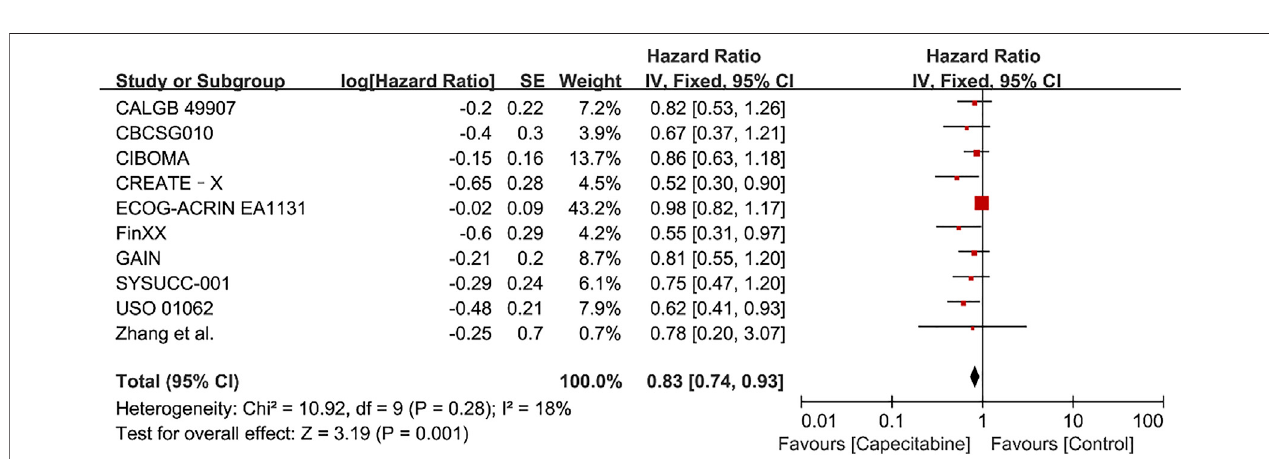
FIGURE 5 | Forest plots for the overall survival (OS) rate in the comparison between chemotherapy with capecitabine group vs. capecitabine-free group in TNBC patients.